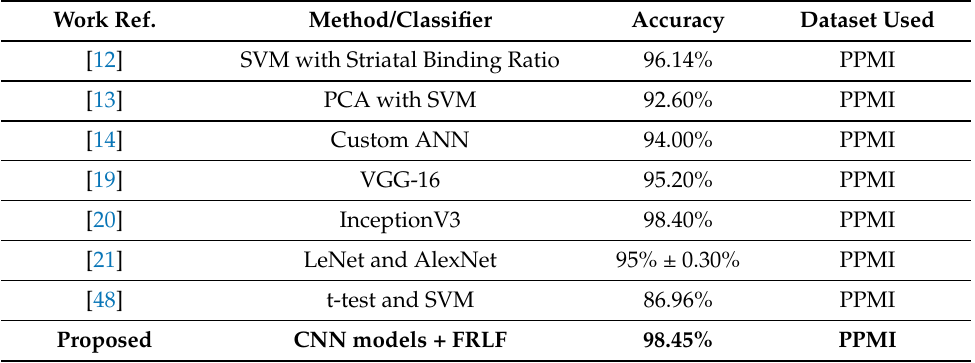
Table 5. Comparison of our proposed method with some past methods found in the literature. Work